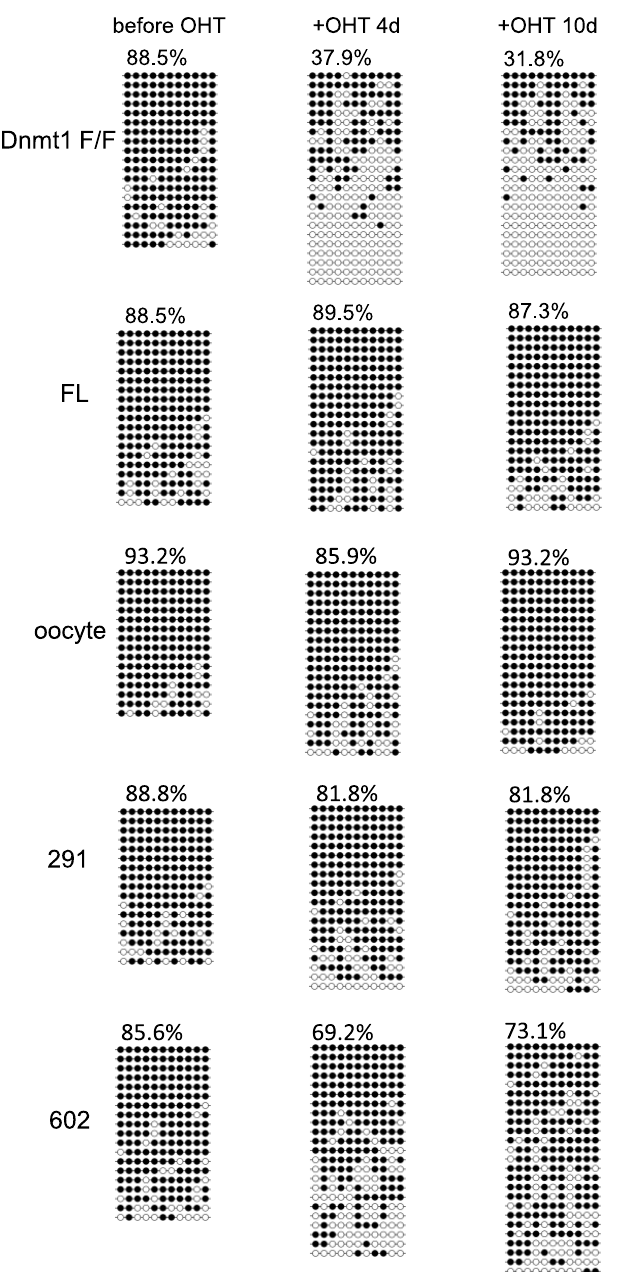
Fig 2. DNA methylation analyses of the gag of IAP . The methylation state of the genome DNA prepared from ESC expressing no Dnmt1 ( Dnmt1 F/F), or full-length Dnmt1 (FL), oocyte-type Dnmt1 (oocyte), Dnmt1 (291 – 1620) (291), or Dnmt1(602 – 1620) (602) four or ten days after addition of OHT. The methylation states of the gag of IAP are shown with that of the parent cells before ( Dnmt1 -F/F) and after the OHT treatment ( Dnmt1 -F/F+OHT). Each horizontal line indicates the CpGs in one analyzed clone. Each circle indicates one CpG site, methylated (filled circles) or un-methylated (open circles). The percentages of methylation are indicated at the